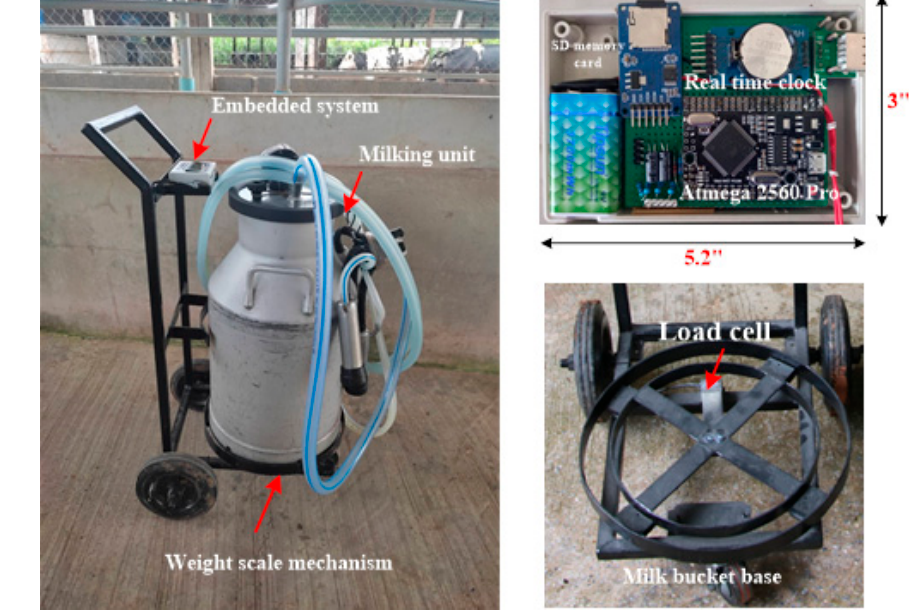
Figure 9. Prototype of the proposed system.